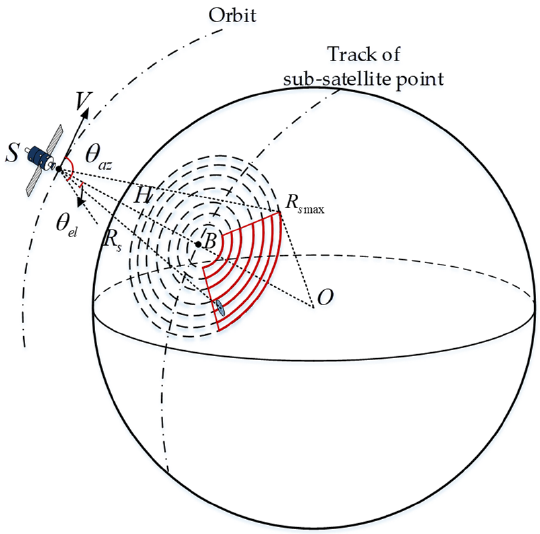
Figure 1. Working geometric model of SBEWR.